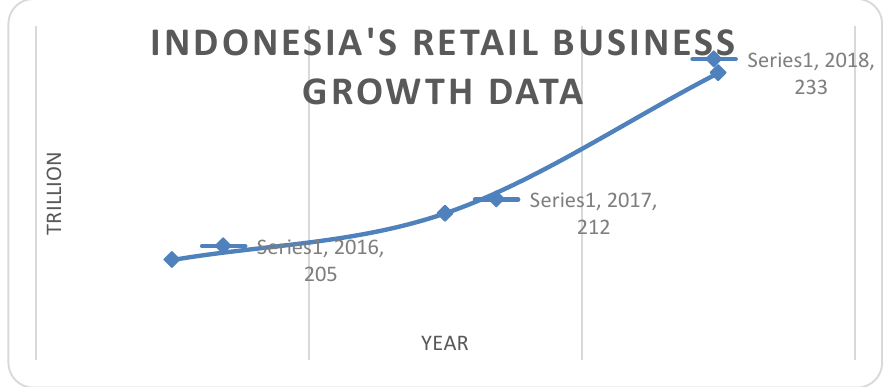
Figure 1: Indonesia's Retail Business Growth